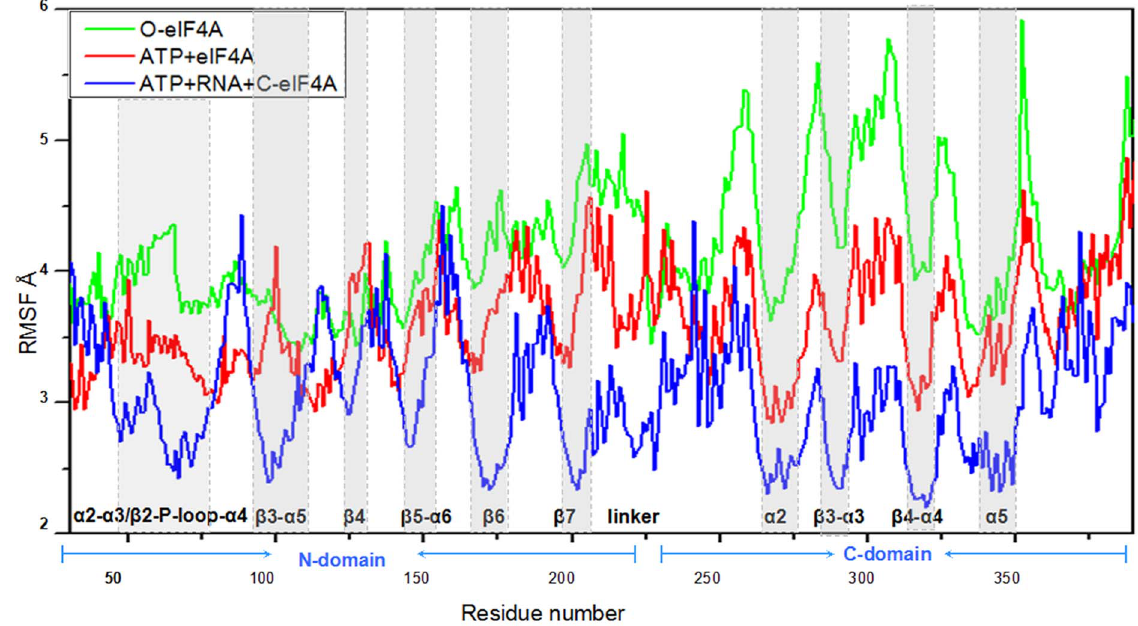
Figure 10. The fluctuations of residues. The fluctuations of residues in the O-eIF4A (green), ATP + eIF4A (red) and ATP + RNA + C-eIF4A (blue) models with the labeled a helices and b strands at the ATP/RNA binding region and the N-domain – C-domain interface in the shaded regions.